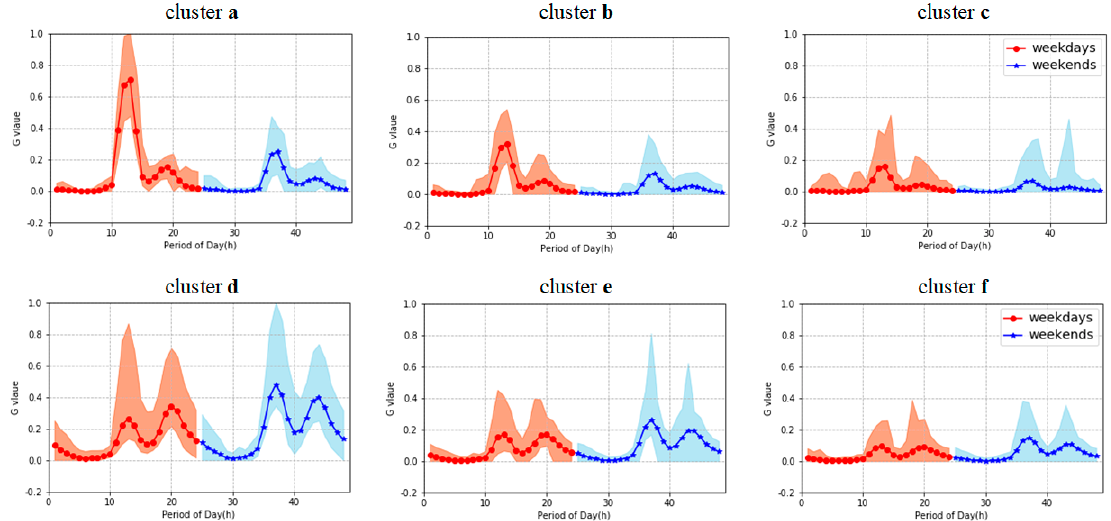
Figure 8. Cluster results of the time series by using the k-means method with K = 6.